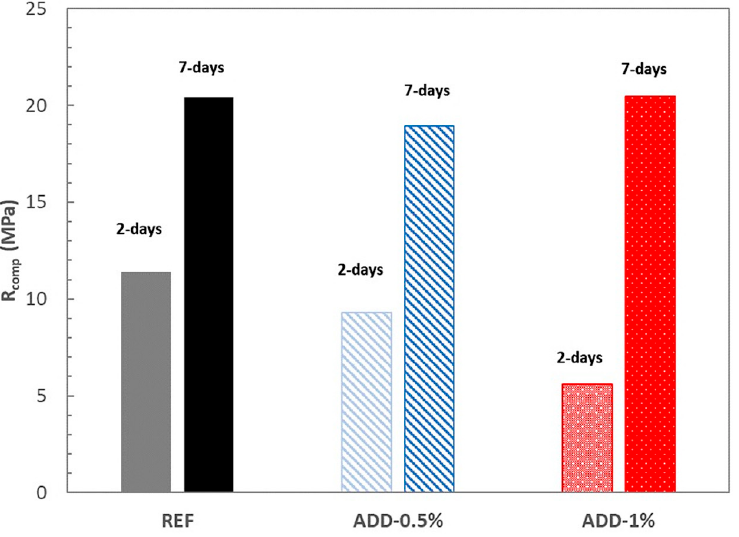
Figure 9. Compressive strength of the mortars cured in high-humidity conditions.